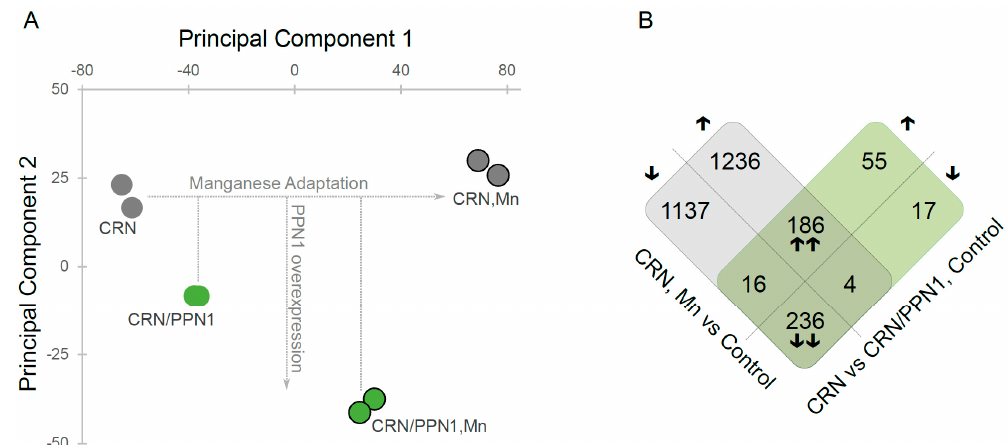
Figure 2. Gene expression profile of the CRN / PPN1 strain is similar to that of the manganese-adapted CRN strain. CRN and CRN / PPN1 were grown in control YPD with 14 mM KH 2 PO 4 and in the same medium supplemented with 5 mM MnSO 4 . ( A ) Principal component analysis of gene expression data: (green circles) CRN / PPN1 samples; (gray circles) CRN samples. Circles denoting the samples grown in manganese excess conditions (Mn) are outlined. ( B ) Venn-like diagram for genes up- and down-regulated in (gray) CRN in control YPD versus CRN in manganese-supplemented YPD; (green) CRN / PPN1 as compared to CRN, both in control YPD. Each cell shows the number of genes; the direction of expression change (up- or down-regulation) is shown with arrows. Up- or down-regulated genes in both comparisons are indicated by double arrows.